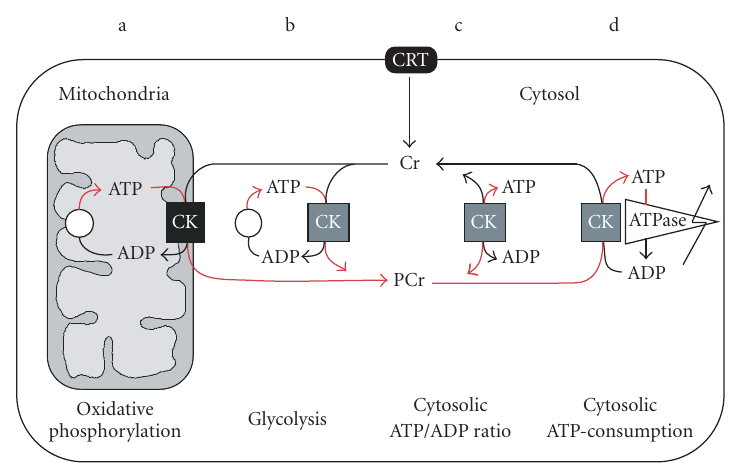
Figure 1: The CK/PCr